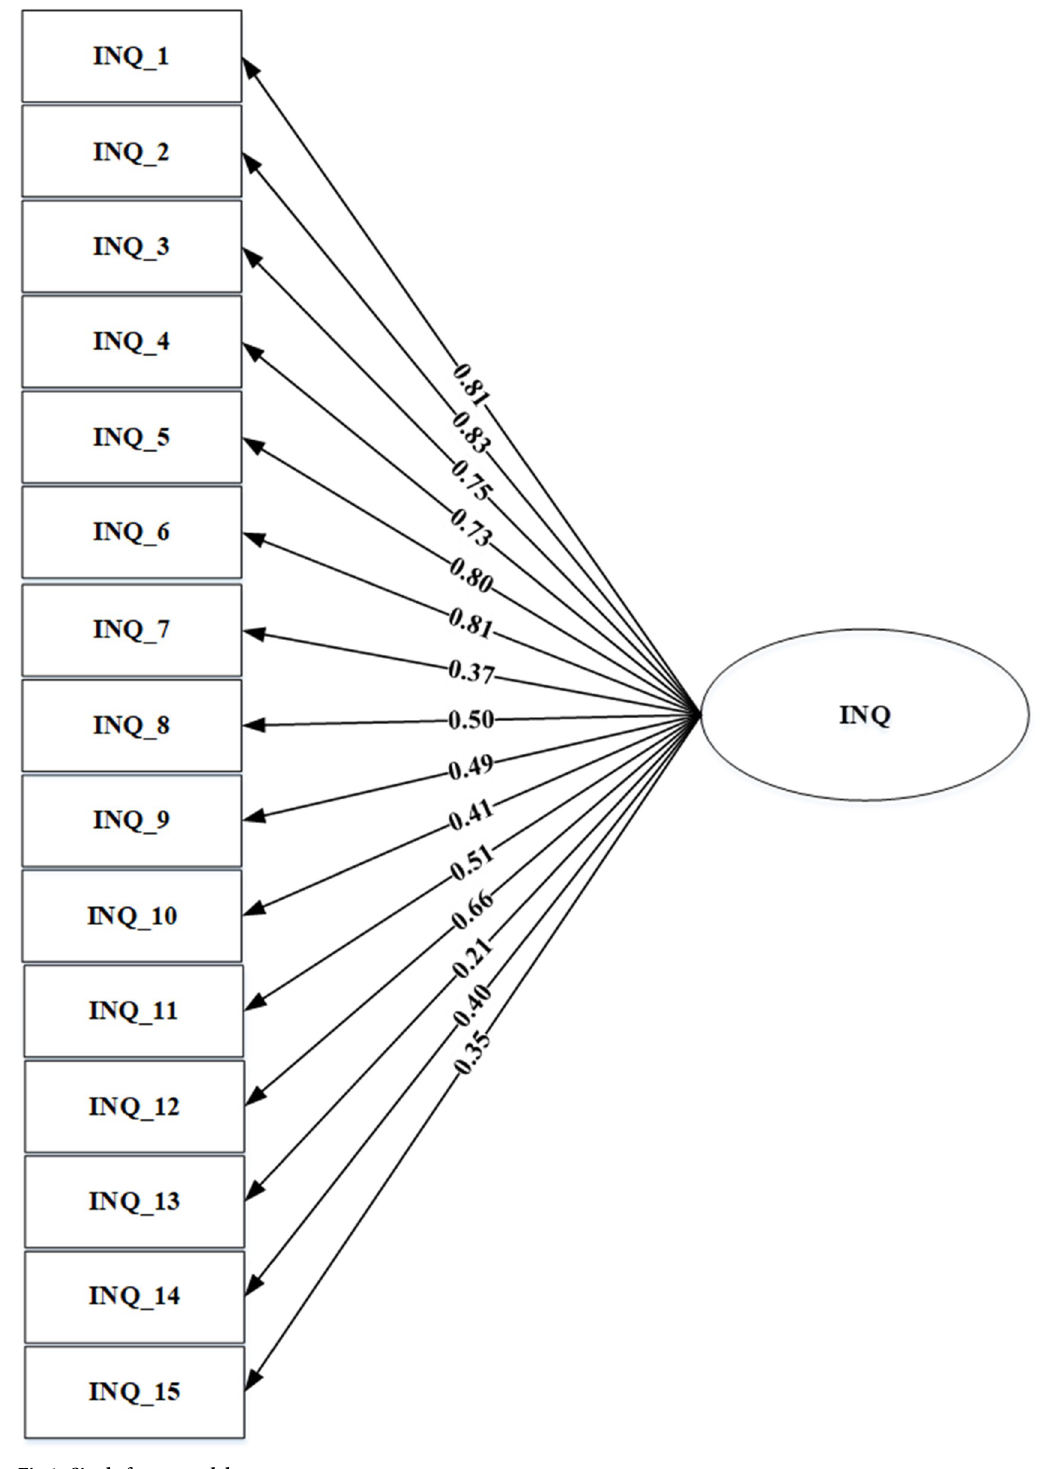
Fig 1. Single factor